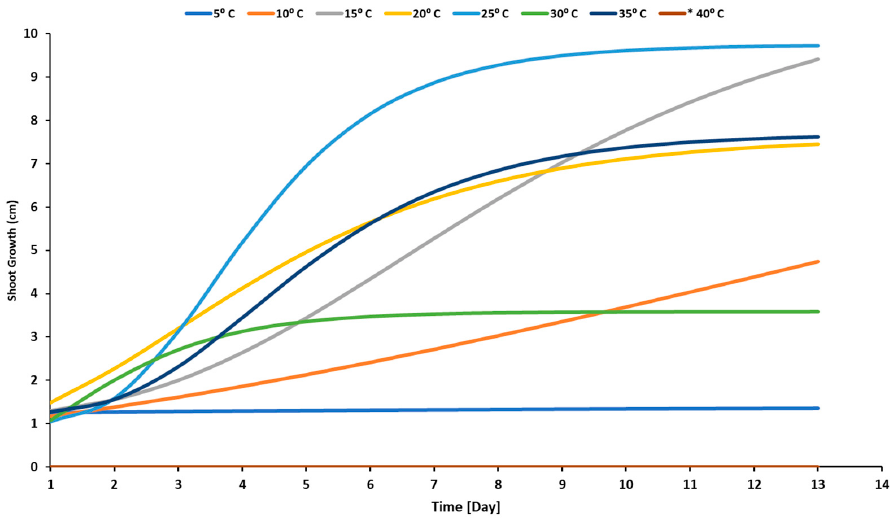
Figure 4. Effect of temperature levels on the growth response of shoot. The * represents 40 °C which is not shown on the graph because its value is zero (no shoot growth).